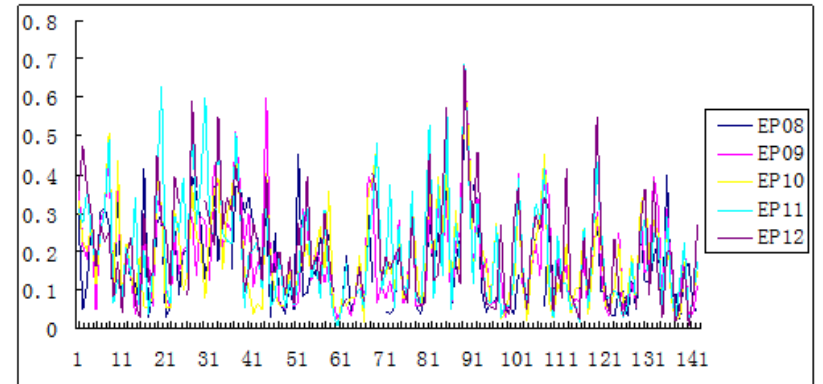
Figure 1. Corporate environmental performance in heavy-pollution industries